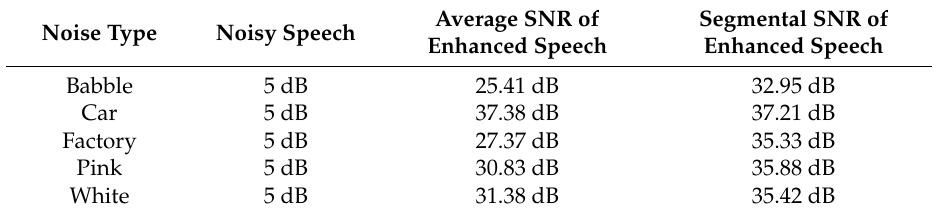
Table 2. Average values of SNR and segmental SNR of noisy speech (5 dB) and enhanced speech.